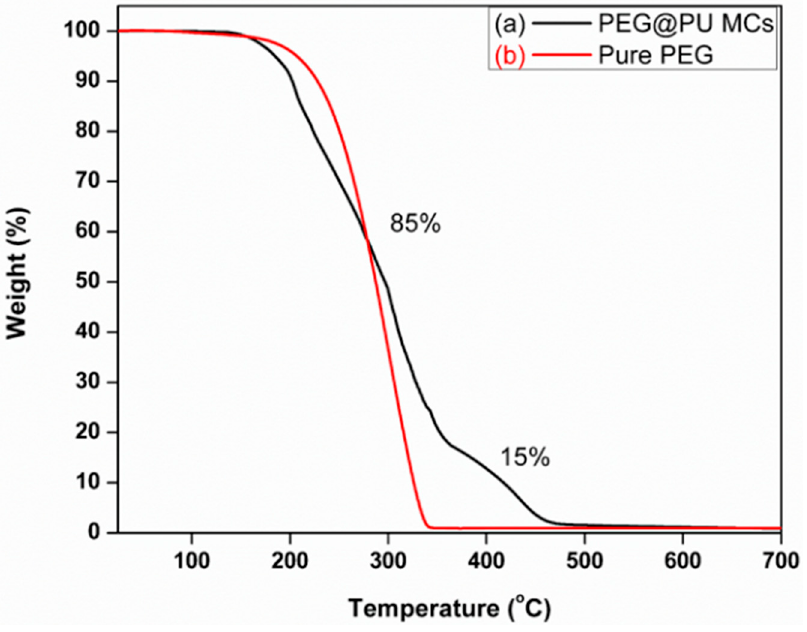
Figure 2. Thermogravimetric analysis (TGA) curves of ( a ) PEG 200 @PU MCs and ( b ) pure PEG200.